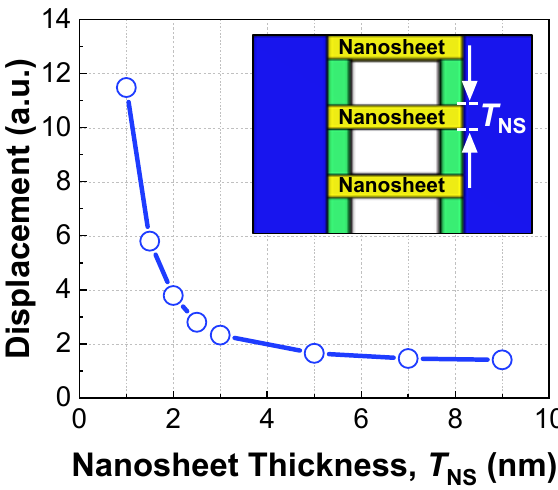
Figure 4. Extracted mechanical displacement with various channel thicknesses.